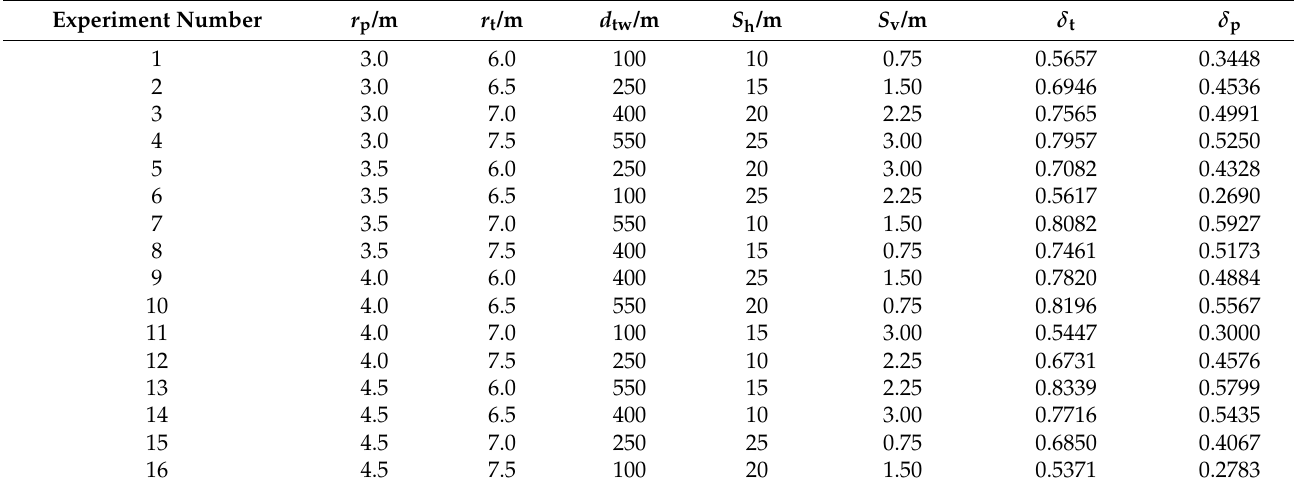
Table 3. Scheme and results of the orthogonal experiment.